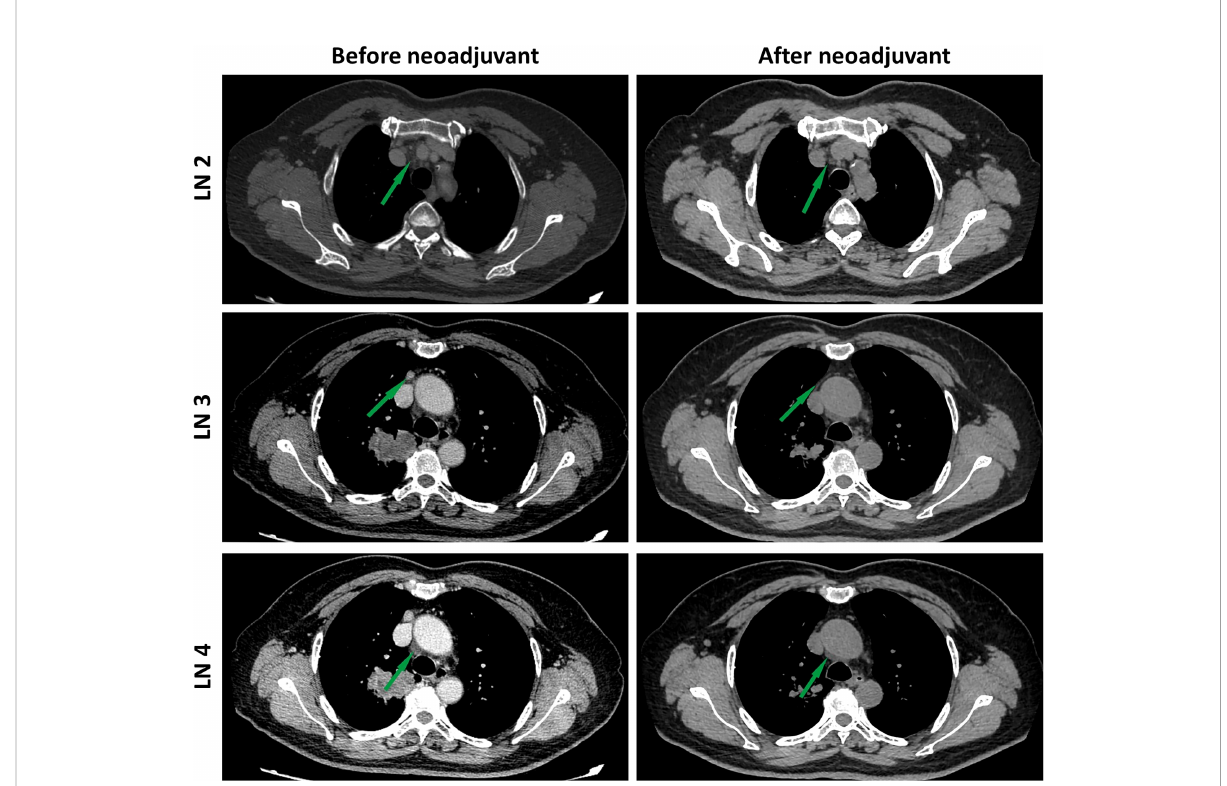
FIGURE 2 Images during neoadjuvant savolitinib treatment. Enhanced chest CT images of lymph nodes before and after the neoadjuvant therapy. The lymph nodes pointed by green